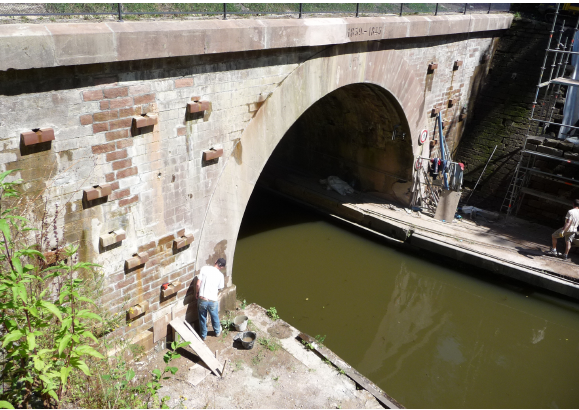
Figure 1: Restoration of Niderviller’s tunnel masonry in